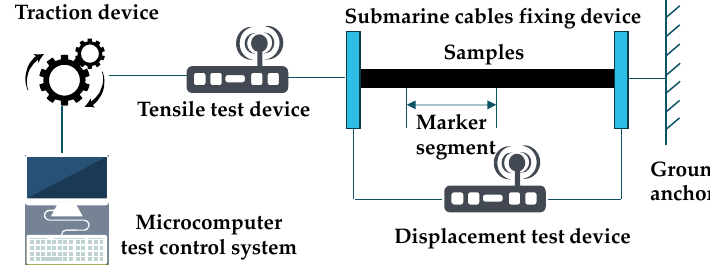
Figure 4. Tensile test schematic [21].